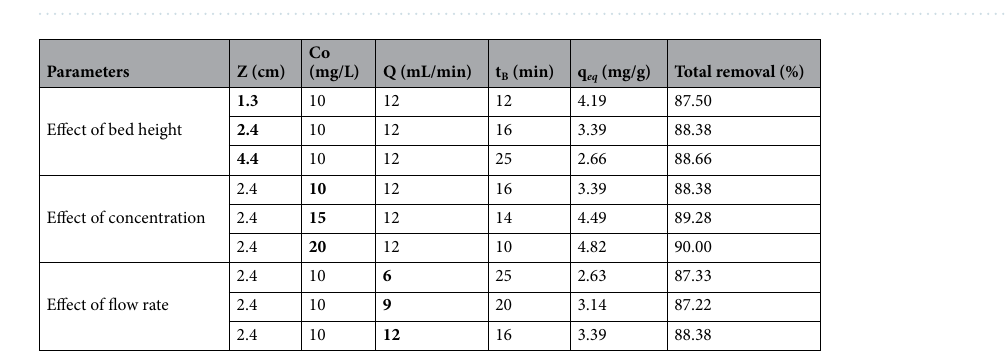
Figure 8. Effects of bed heights ( a ), cadmium concentrations ( b ) and flow rates ( c ) on breakthrough curves of cadmium adsorption on ACH.